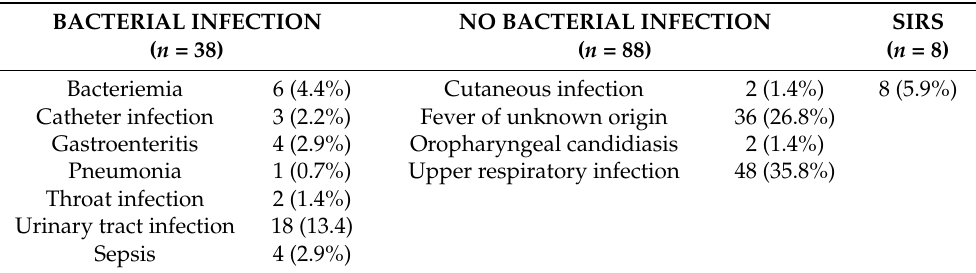
Table 2. Episodes final diagnosis and location of infections.